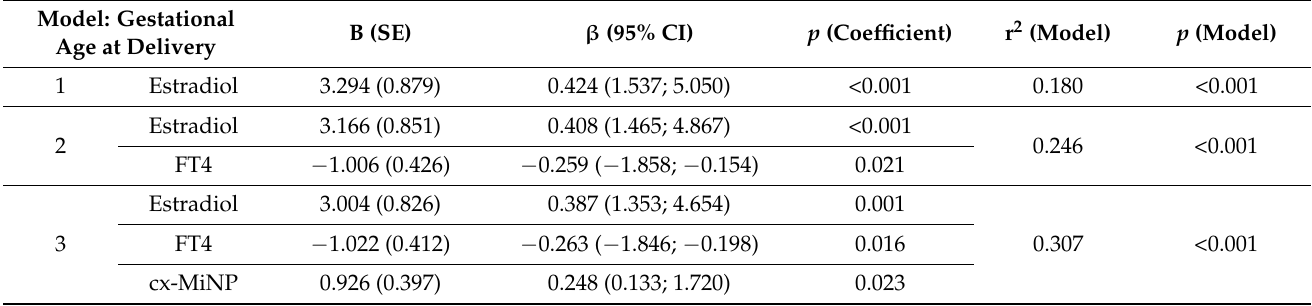
Table 9. Relationship between neonatal parameters and maternal endocrine parameters (third trimester of pregnancy) in the context of phthalate